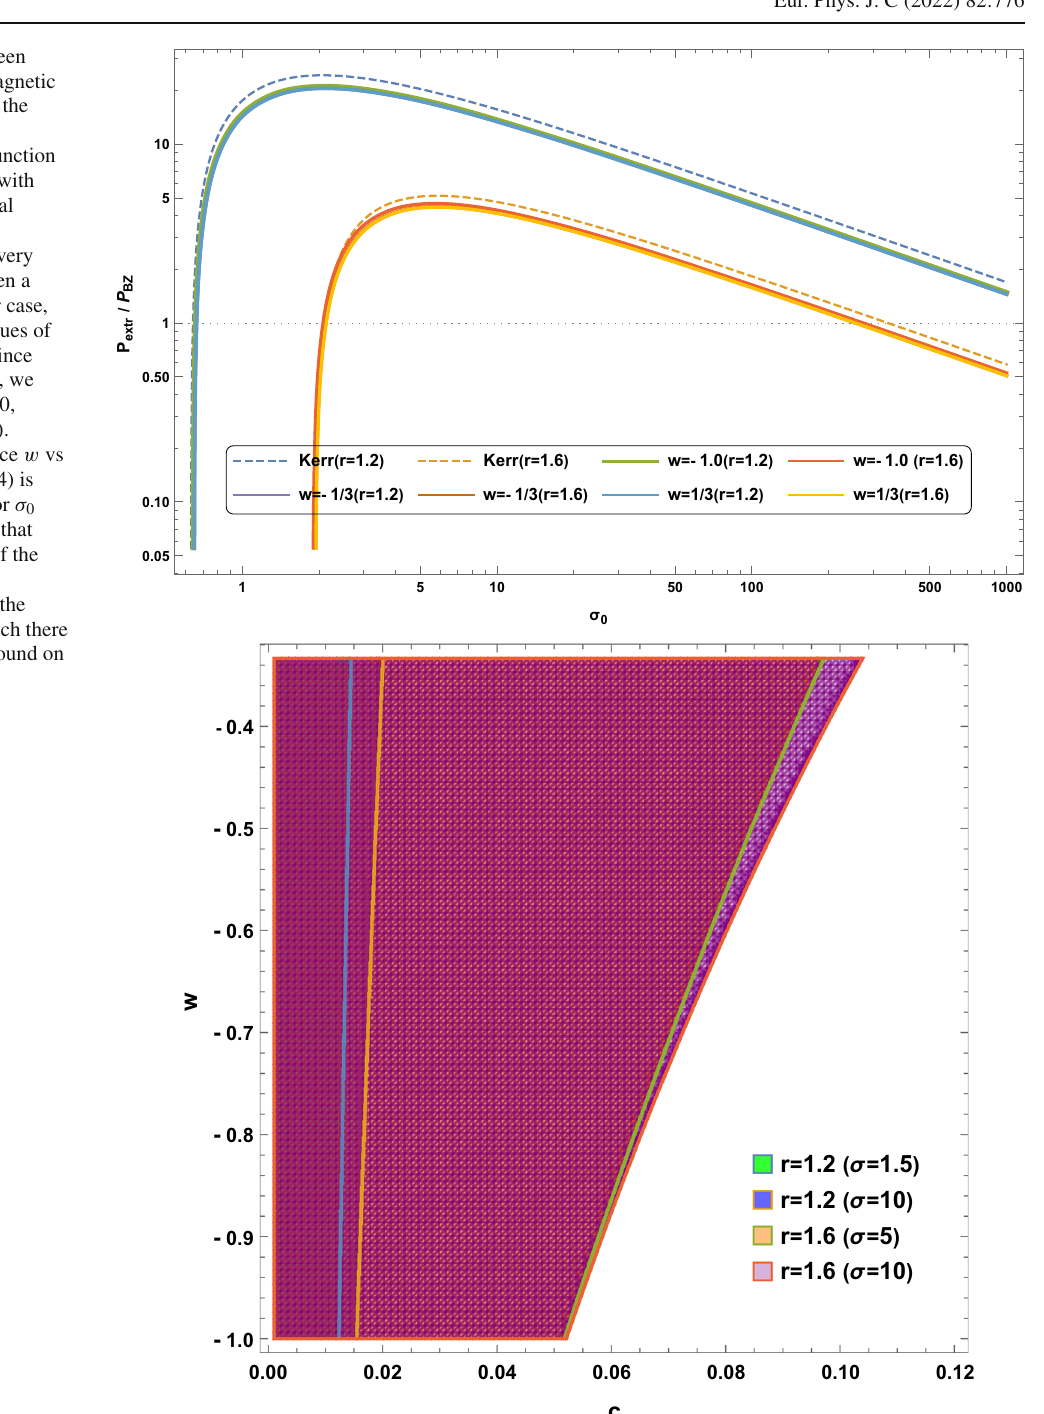
Fig. 6 (Top) Rate between power extracted from magnetic reconnection, P extr , and the same quantity from BZ mechanism, P BZ , as a function of the X-point distance, with ζ = π/ 12 and the optimal conditions a → 1 and c = 1 / 1000. Notice the very similar behaviour between a Kiselev BH and the Kerr case, and also for different values of w (only some shown). Since here we assumed a → 1, we computed r + from (cid:17) = 0, rather than from Eq. (26). (Bottom) Parametric space w vs c for which condition (14) is true. Different options for σ 0 and r are shown. Notice that increasing the distance of the latter or increasing the magnetization increases the range of c values for which there is extraction, while no bound on w is evident